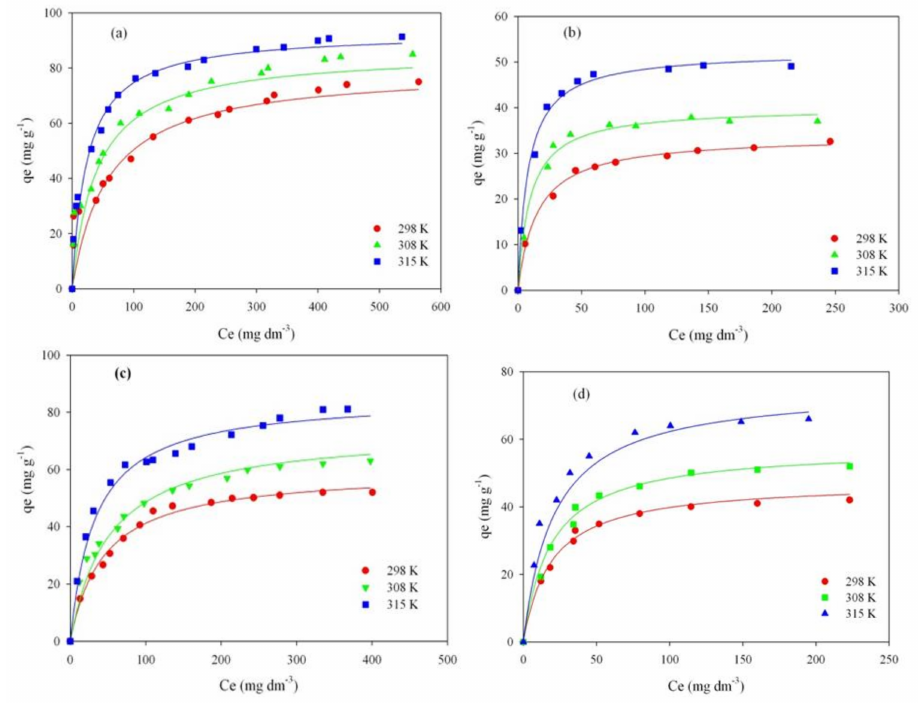
Figure 5. Adsorption isotherms of RB on ST-A ( a ) and CWZ-22 ( c ), and AY17 on ST-A ( b ) and CWZ-22 ( d ). Table 5. Comparison of the q m of RB and AY17 on different